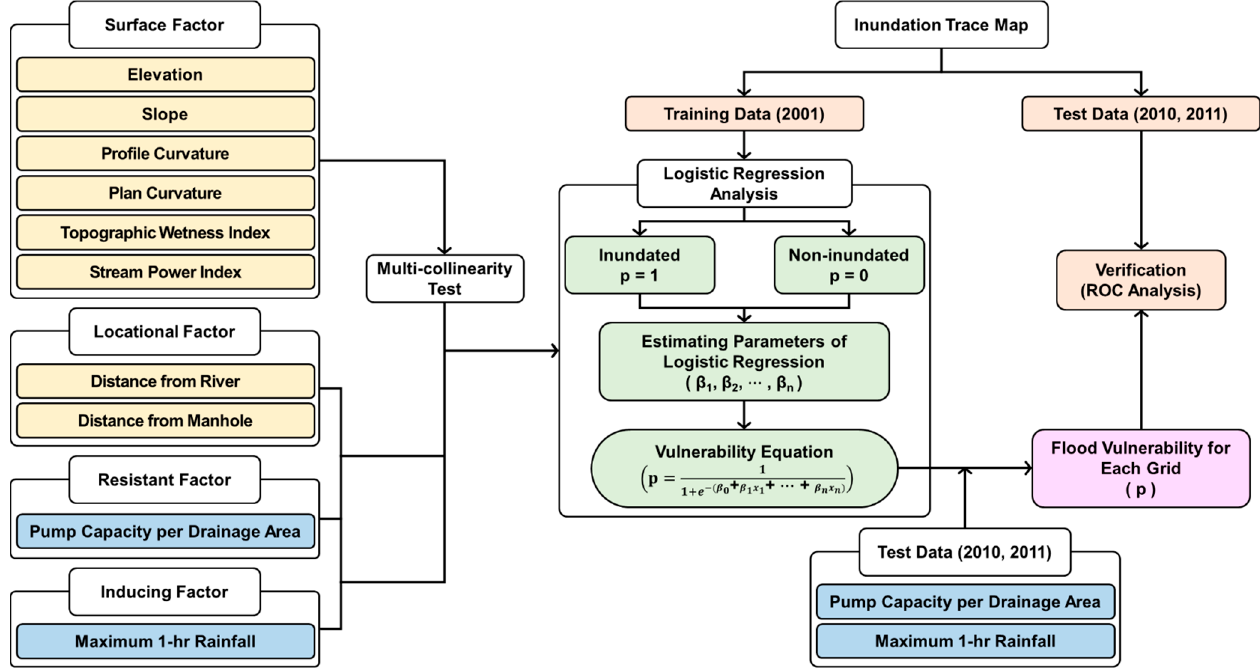
Figure 1. Flow chart of this study.